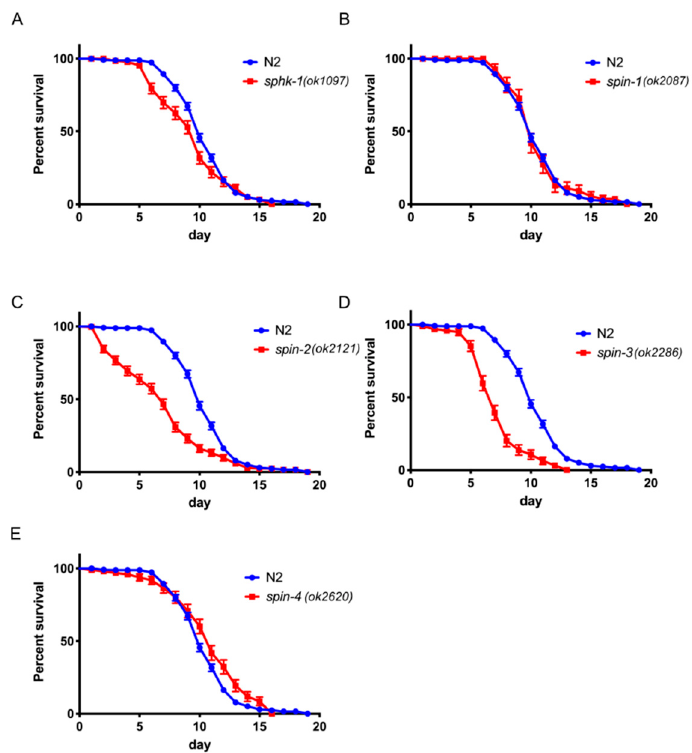
Figure 2. Sphingosine kinase and S1P transporters control the immune response toward E. faecalis MMH594 in C. elegans . Survival of worms with mutation in sphingosine kinase, sphk-1 ( A ), or S1P transporters spin-1 ( B ), spin-2 ( C ), spin-3 ( D ), and spin-4 ( E ) and wild type N2 on E. faecalis MMH594. The log-rank (Mantel-Cox) test was used for statistical analysis of worm survival.